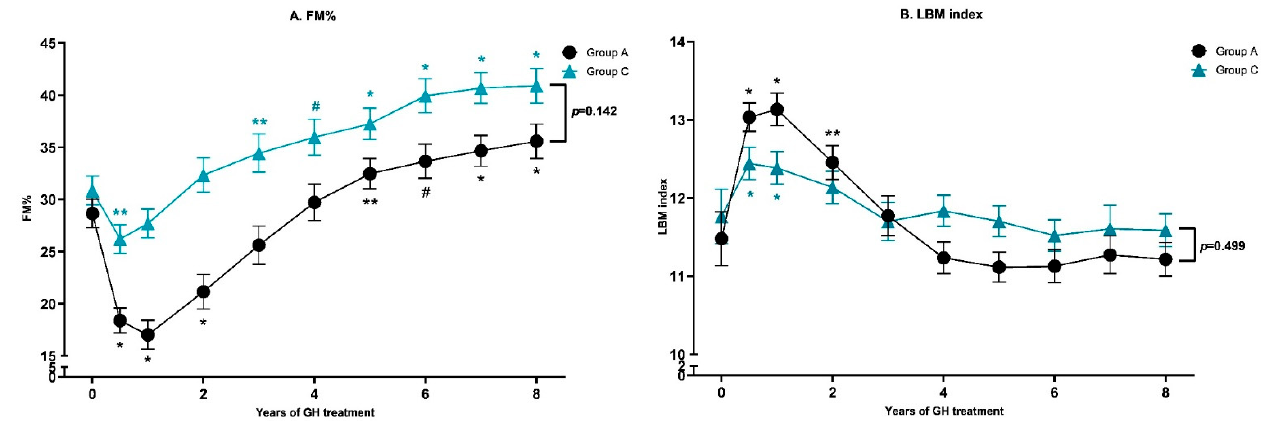
Figure 1. Longitudinal changes in Estimated Marginal Means with SEM in FM% ( A ) and LBM index ( B ) in group A (27 children with PWS, age start GH treatment < 1.05 years) and group C (27 children with PWS, age start GH treatment between 2.27–5.00 years) during 8 years of GH treatment. FM% and LBMI are corrected for sex and pubertal stage. * p -value < 0.001, # p -value < 0.01, ** p -value < 0.05. All these p -values are compared to baseline, p -values indicated by the brackets are referring to the difference between the subgroups after 8